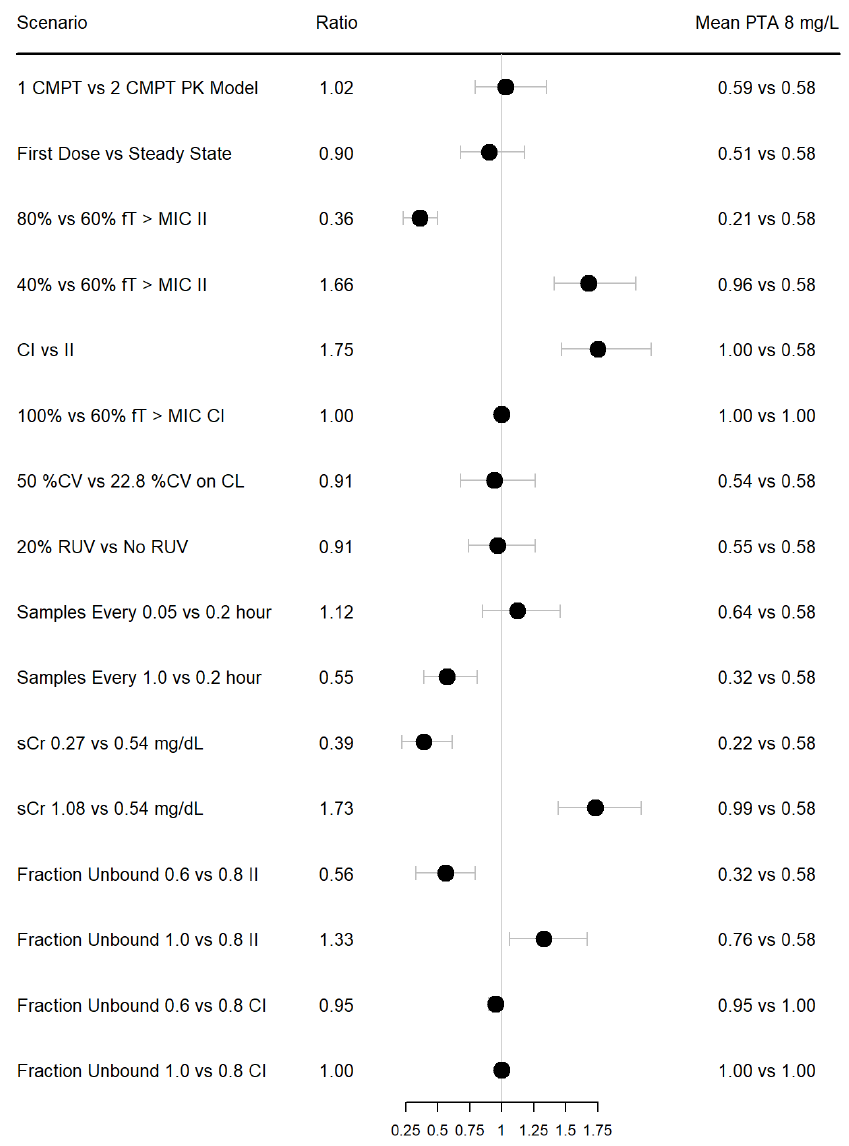
Figure 1. Forest plot of ratio of mean PTA under different simulation conditions using a population PK model developed by Á lvarez et al. Dosing used was 2000 mg IV q8 h over 30 min unless otherwise stated. Continuous infusions matched the total daily dose of 6000 mg. Samples were simulated every 0.2 h unless otherwise stated. Error bars represent 90% CIs. II = intermittent infusion; CI = continuous infusion; RUV = residual unexplained variability; sCr = serum creatinine.